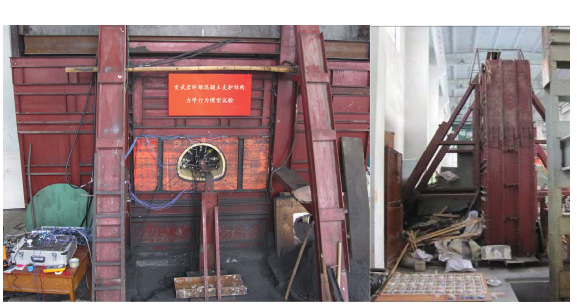
Figure 2: Test bench.